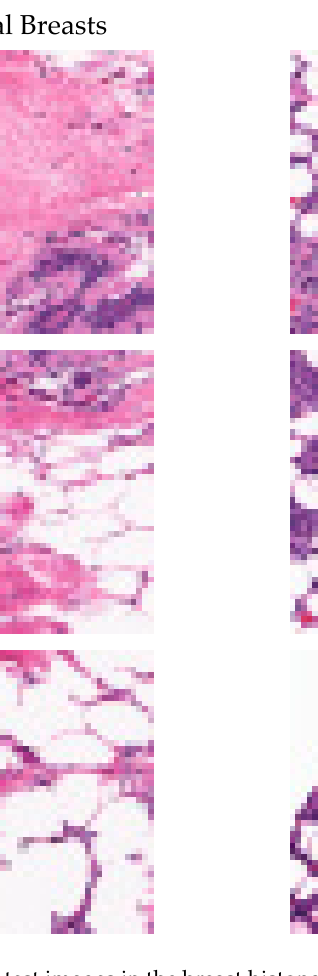
Figure 2. The test images in the breast histopathological imaging dataset for both classes. Both the healthy and malignant breast tissues with IDC can be observed on the microscopic slides. The 3D U-Net model receives the preprocessed patches as input. The characteristics of both malignant and healthy tissue are learned by the model during training with the IDC-positive and IDC-negative patches. When the model is fine-tuned, its IDC detection performance is assessed using a testing dataset. Figure 3 displays the distribution of patches across different classes in the dataset. The colors represent the different classes or categories of ductal carcinoma in the target variable with blue indicating category 0 and orange representing category 1. The class labels “0” and “1” are assigned to IDC-negative (healthy tissues) and IDC-positive (malignant tissues), respectively.